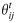
Dynamic network inference from monkey V4 data.In this experiment, a 90° grating on a screen was presented to the monkey for 2s (light gray shaded areas). 1004 trials were recorded, and binary spike trains were constructed with bin width of 10 ms. A Top: Exemplary spiking data (N = 45). Bottom: Empirical probability (black) of observing a spike over time and spike probability of the fitted model (green). B Top: The fitted network at three different time points, before, during, and after stimulation. Edges with significantly non-zero θijt are displayed (as in Fig 1). Bottom: The mean of smoothed MAP estimates for θit and θijt (dark gray line). The shaded area is the mean ± standard deviation. C Credible intervals of macroscopic measures of the network over time obtained from the smoothed estimates of the model (light color). Dark shaded area corresponds to the credible intervals of the estimates for trial shuffled data.